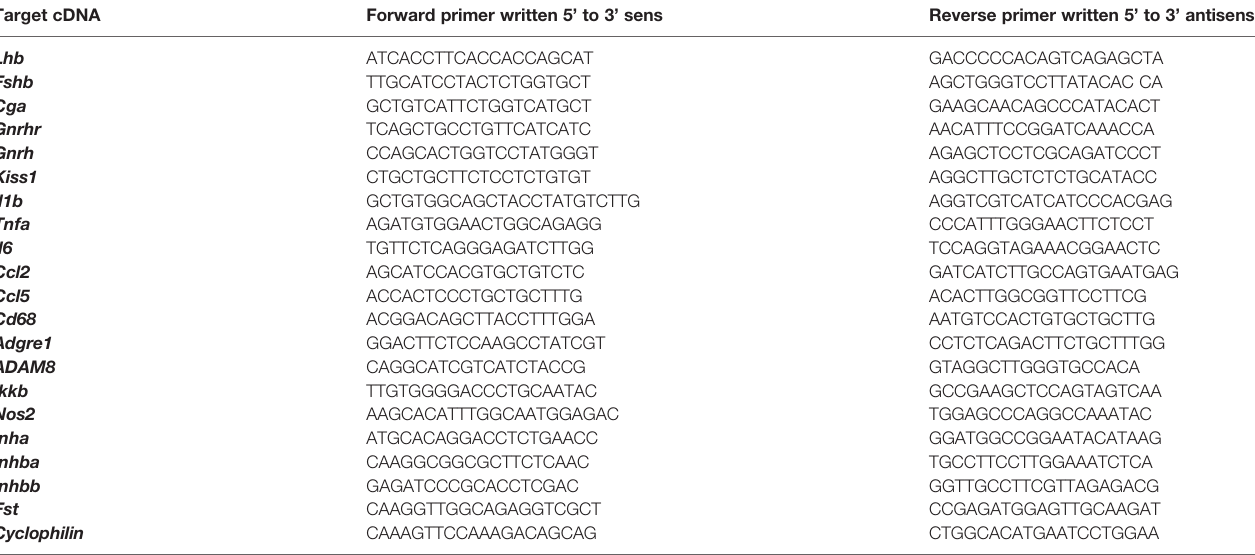
TABLE 1 | Sequences of the primers and probes used for quanti fi cation of transcript levels in rat tissues. Target